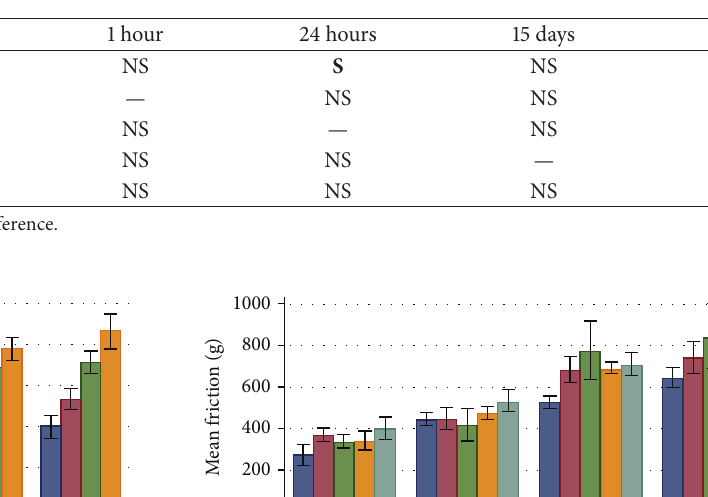
Table 2: Post hoc Tukey’s test for Group I (Alastik).